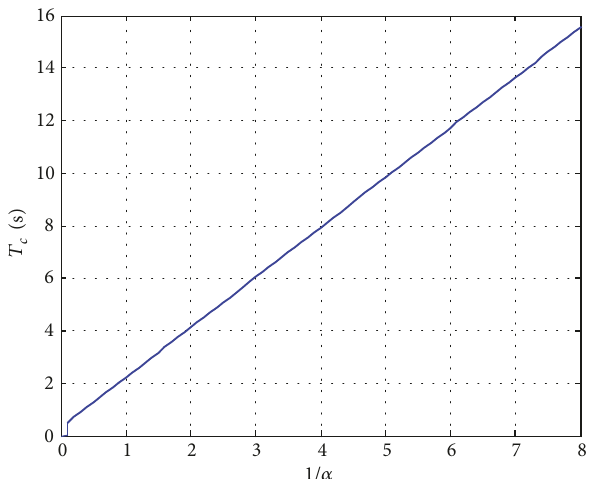
Figure5:Therelationshipbetweenconvergencetimeandreciprocal of adaptive control